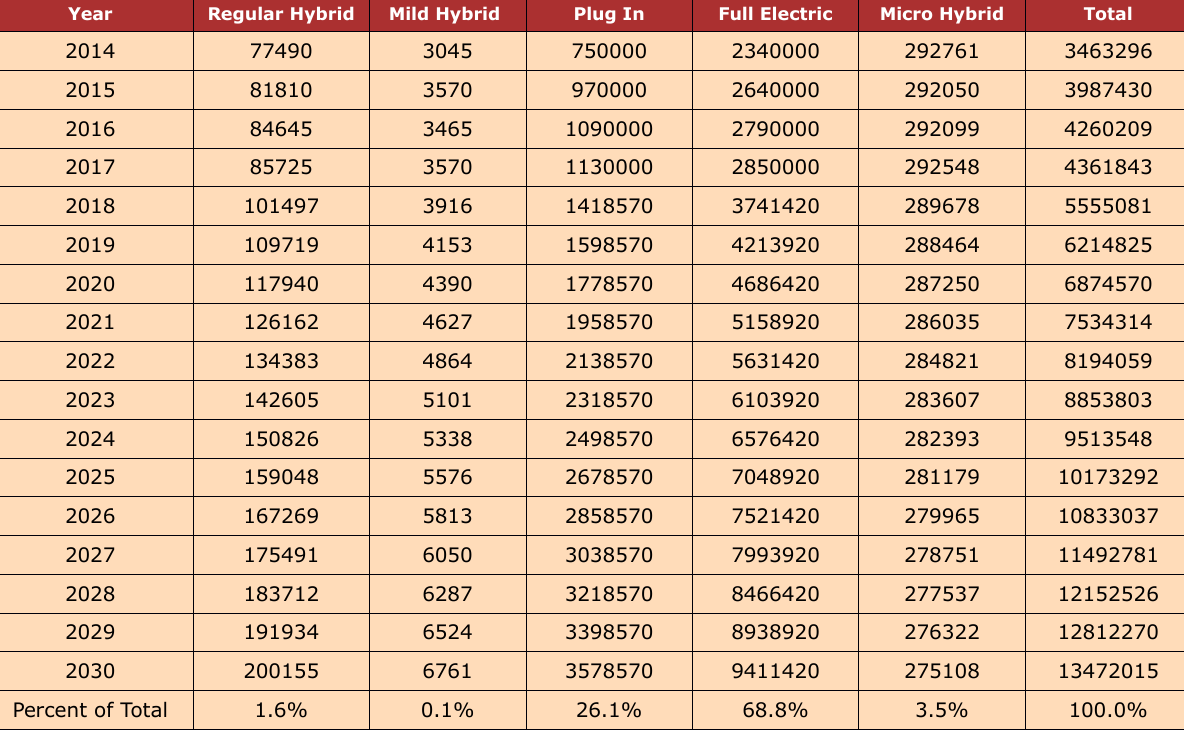
Table 6. Power in Batteries of Electrified Vehicles (in